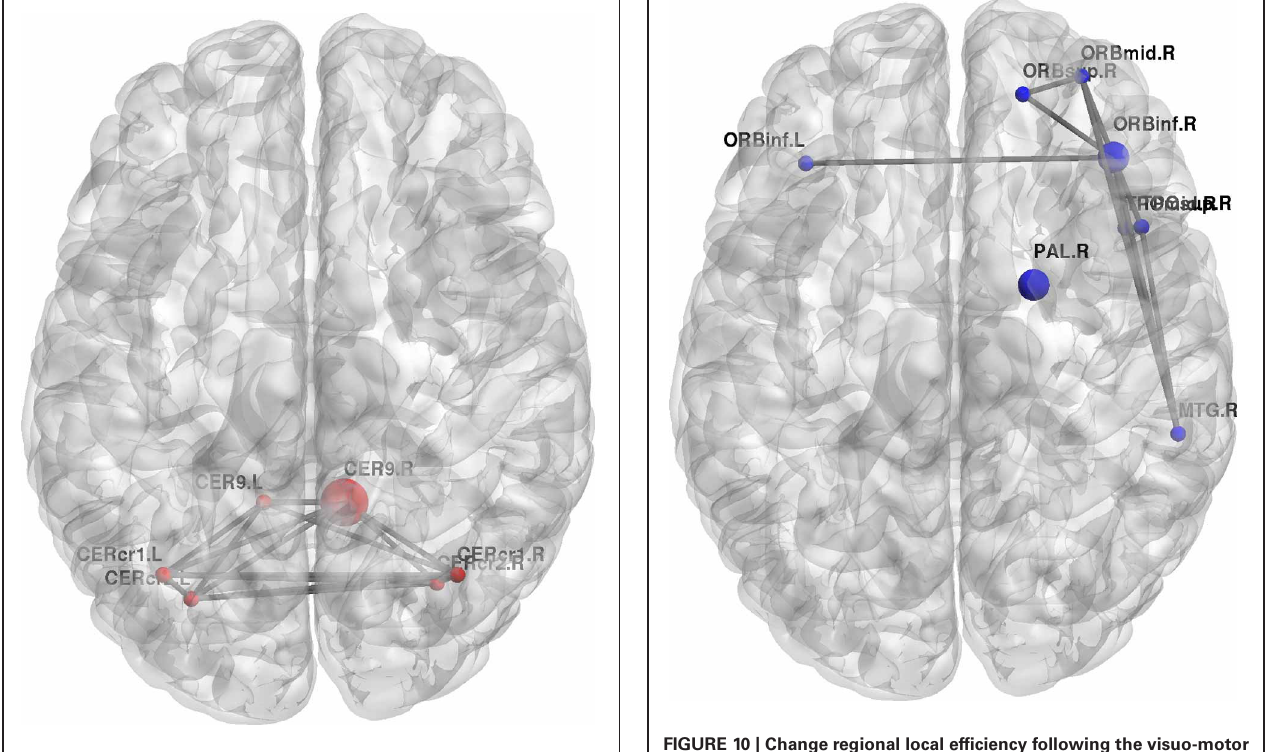
adaptation learning task 3; purple, visuo-motor performance task 4; blue, Group mean is represented by the solid line while shaded areas indicate